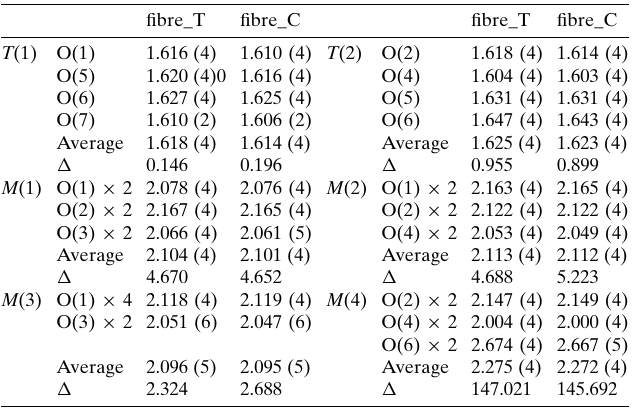
Table 3 Selected bond distances (in A ˚ ) and polyhedral distortion ( (cid:2) (cid:6) 10 (cid:3) 4 ) for fibre_T and fibre_C. Note: polyhedron distortion (cid:2) as defined by Shannon (1976), (cid:2) = (1/ n ) (cid:3) [( R i (cid:3) R )/ R ] 2 , where n is the number of ligands, R is the average bond length and R i is an individual bond